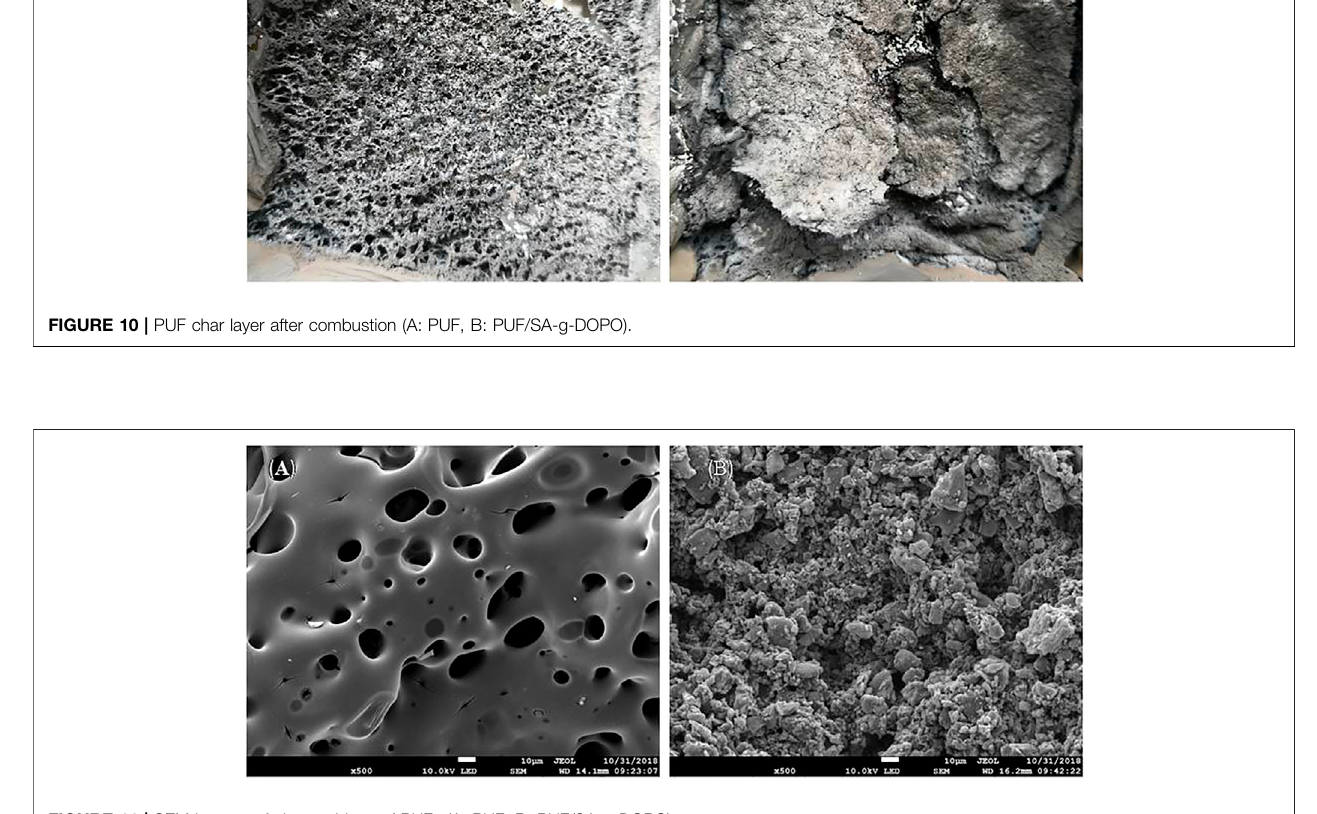
FIGURE 11 | SEM images of char residues of PUFs (A: PUF, B: PUF/SA-g-DOPO).